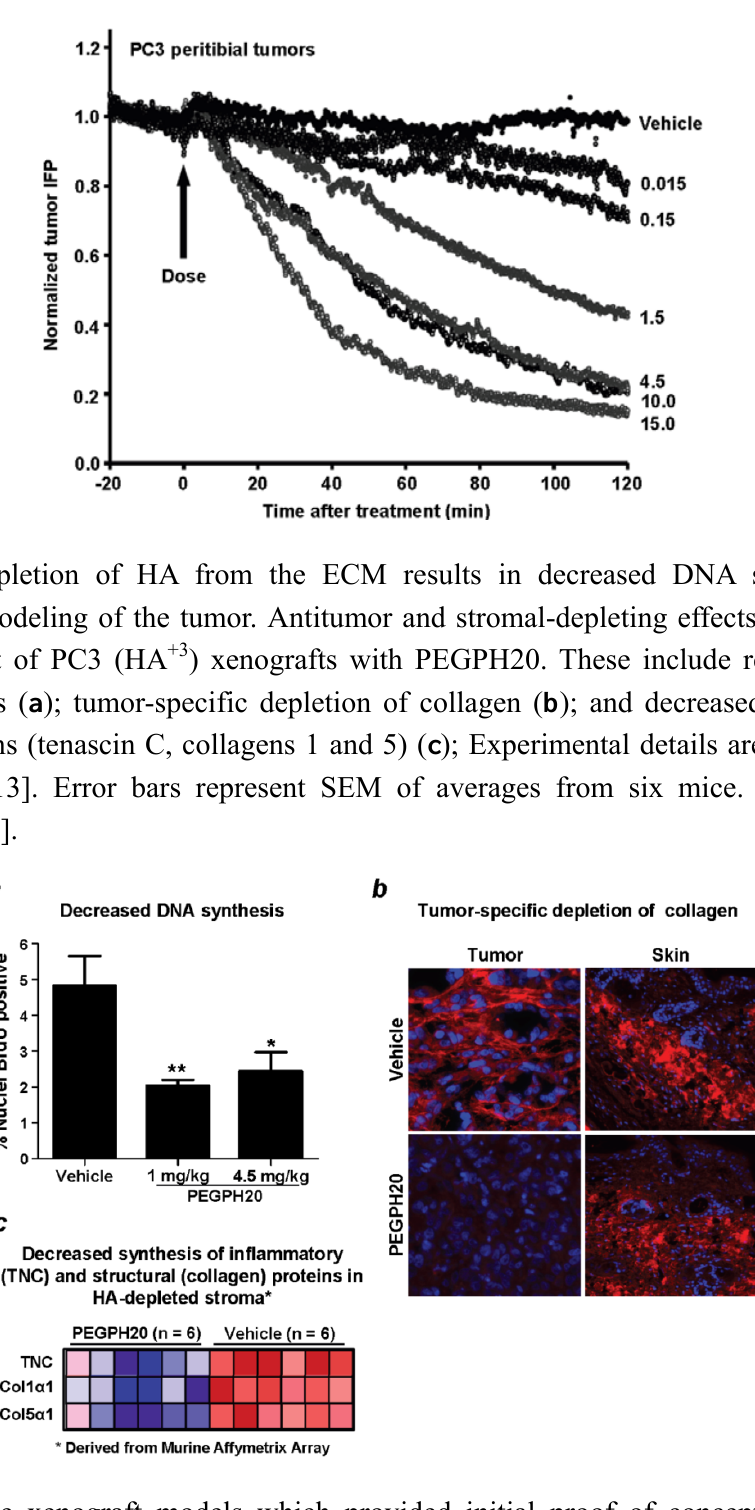
Figure 6. Dose-dependent effect of PEGPH20 in vivo on tIFP in PC3 peritibial tumors. Mice were treated intravenously with 0–15 mg/kg PEGPH20 (doses in mg/kg are shown on the right) and tumor IFP was measured over a 2 h period post-administration. Experimental details are given in Thompson et al. [14]. Reprinted by permission [14].